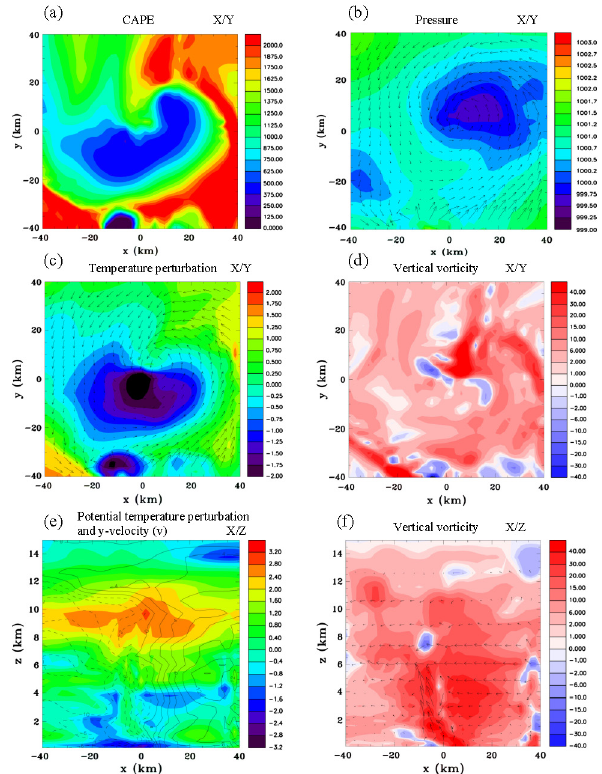
Fig. 16. Horizontal sections for Experiment 2, at t = 80h. (a) Ver- tical vorticity ( × 10 − 4 rad s − 1 ), (b) potential temperature (K), (c) water vapor mixing ratio (g kg − 1 ), (d) pressure (mb), at z = 98 m, and (e) vertical velocity (m s − 1 ), at z = 1 . 6 km.